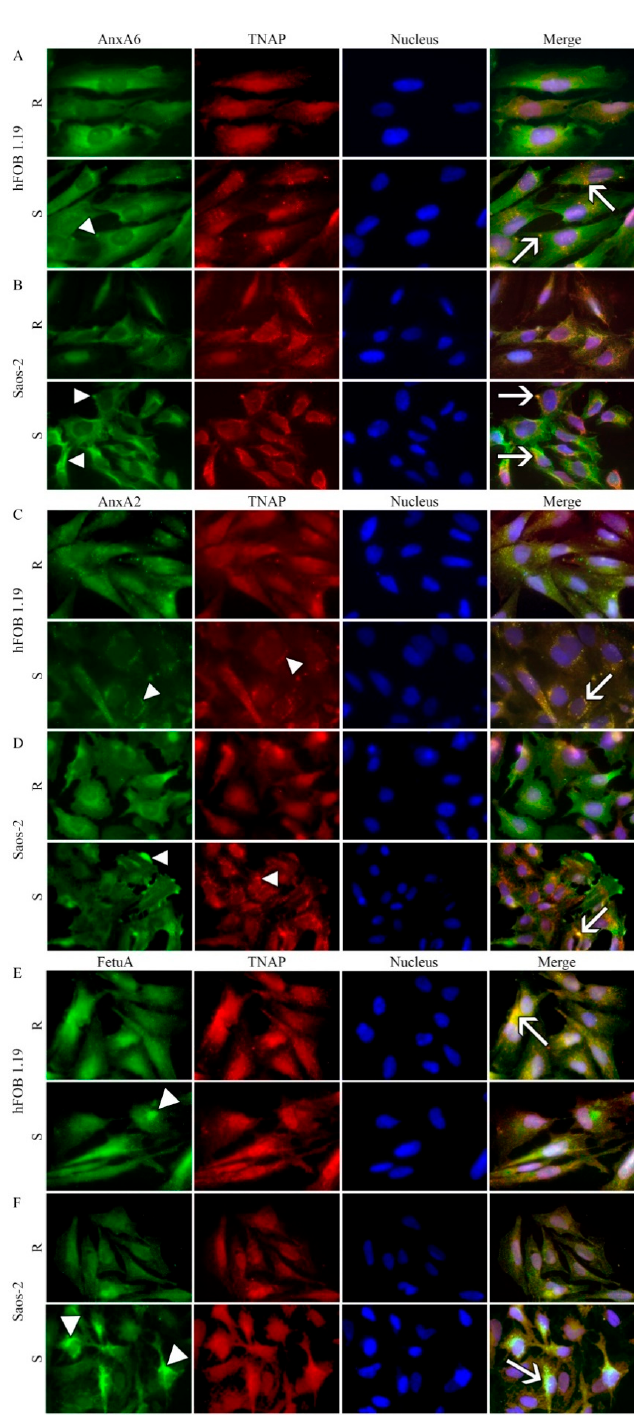
Figure 4. Co-localization of AnxA6, AnxA2, or fetuin-A (FetuA) with TNAP in hFOB 1.19 ( A , C , E ) and Saos-2 ( B , D , F ) cells in resting conditions (R) or after seven-day stimulation with AA and β -GP (S). The cells were incubated with appropriate antibodies: mouse monoclonal anti-AnxA6 ( A , B ), mouse monoclonal anti-AnxA2 ( C , D ), or mouse monoclonal anti-FetuA ( E , F ), all followed by goat anti-mouse IgG-FITC (green); rabbit polyclonal anti-TNAP followed by goat anti-rabbit IgG-TRITC (red) and DAPI for nuclei (blue) and observed under an Axio Observer.Z1 FM (Carl Zeiss, Poznan, Poland) with Phase contrast and appropriate fluorescent filters, magnification 630 x. Arrowheads indicate protein accumulation in vesicular and/or cluster structures. The yellow color and arrows on the merge images indicate AnxA6 ( A , B ), AnxA2 ( C , D ), or FetuA ( E , F ) co-localization with TNAP. Results of a typical experiment are